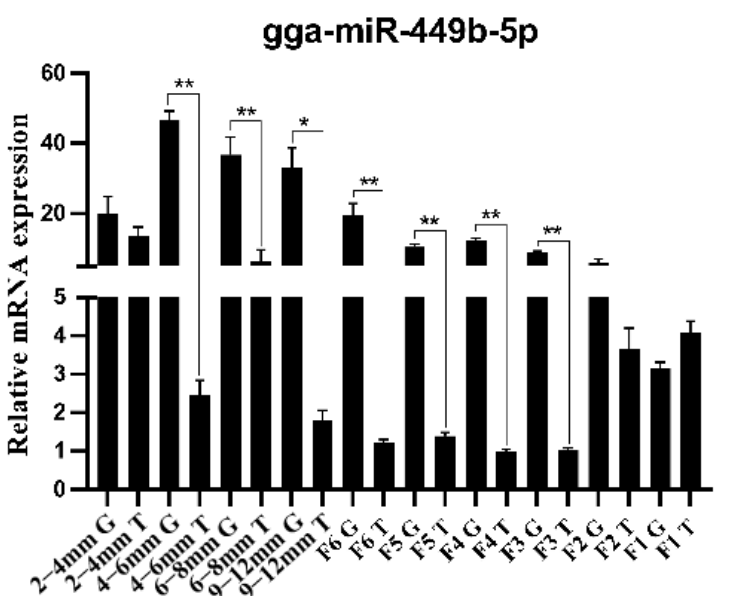
Figure 1. Expression of gga-miR-449b-5p in the TCs and GCs of follicles of different sizes. ** and * indicated that there were significant differences ( p < 0.01) and significant differences ( p < 0.05), re-